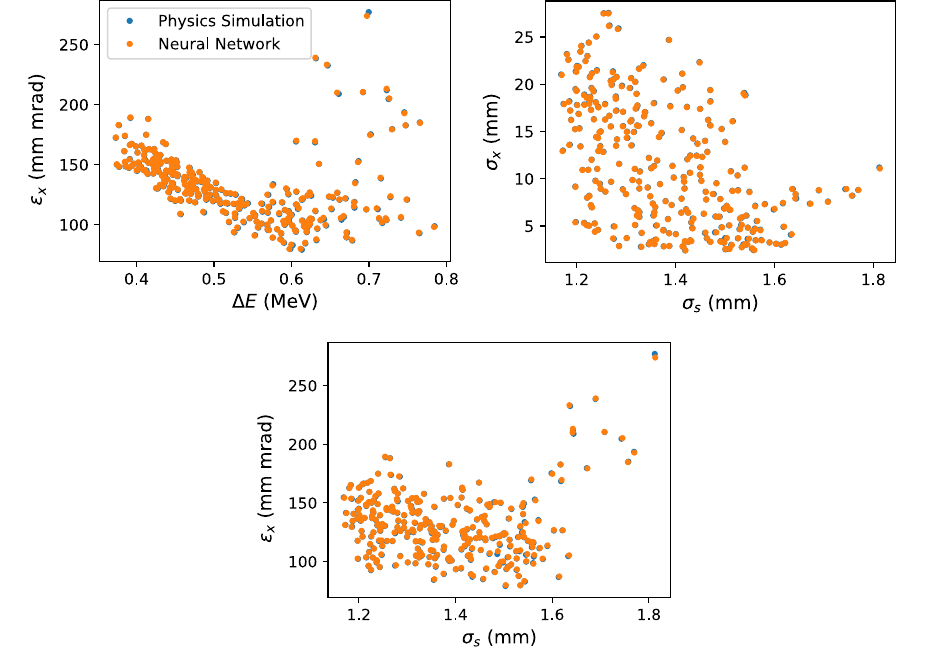
FIG. 9. Point predictions from the NN surrogate model and the corresponding points from the physics simulation, showing that the two are in excellent agreement. These samples are drawn from the test